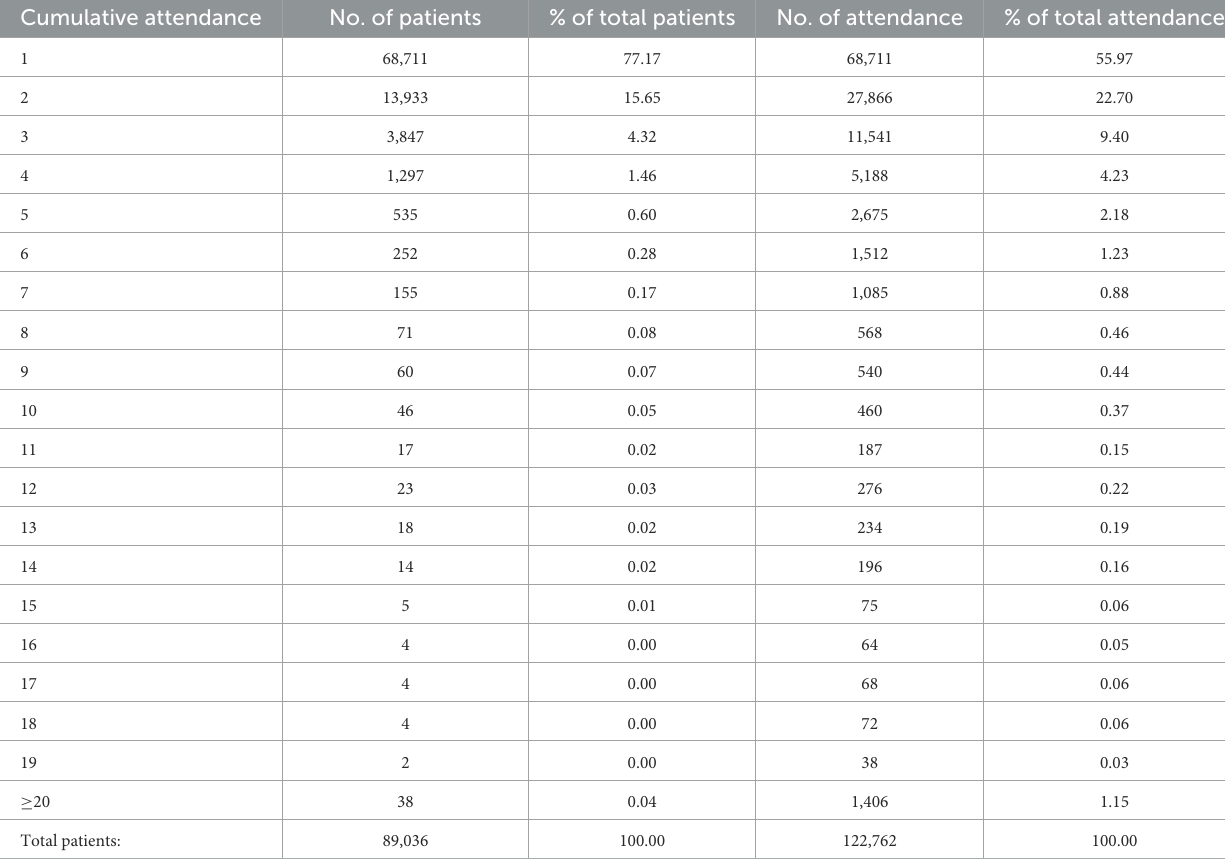
TABLE 1 Distribution of ED attendance and patients during